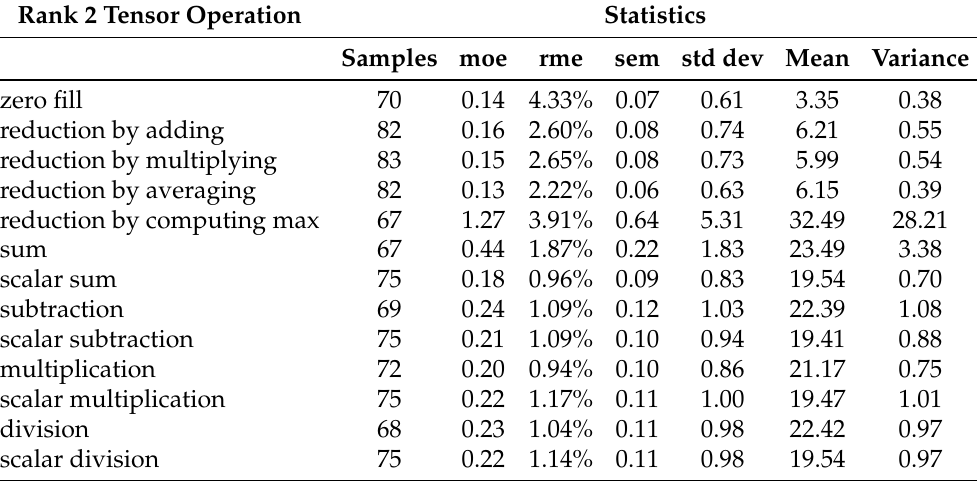
Table 20. Raspberry Pi IV benchmark statistics for rank 2 tensor operations with k = 32 (times in